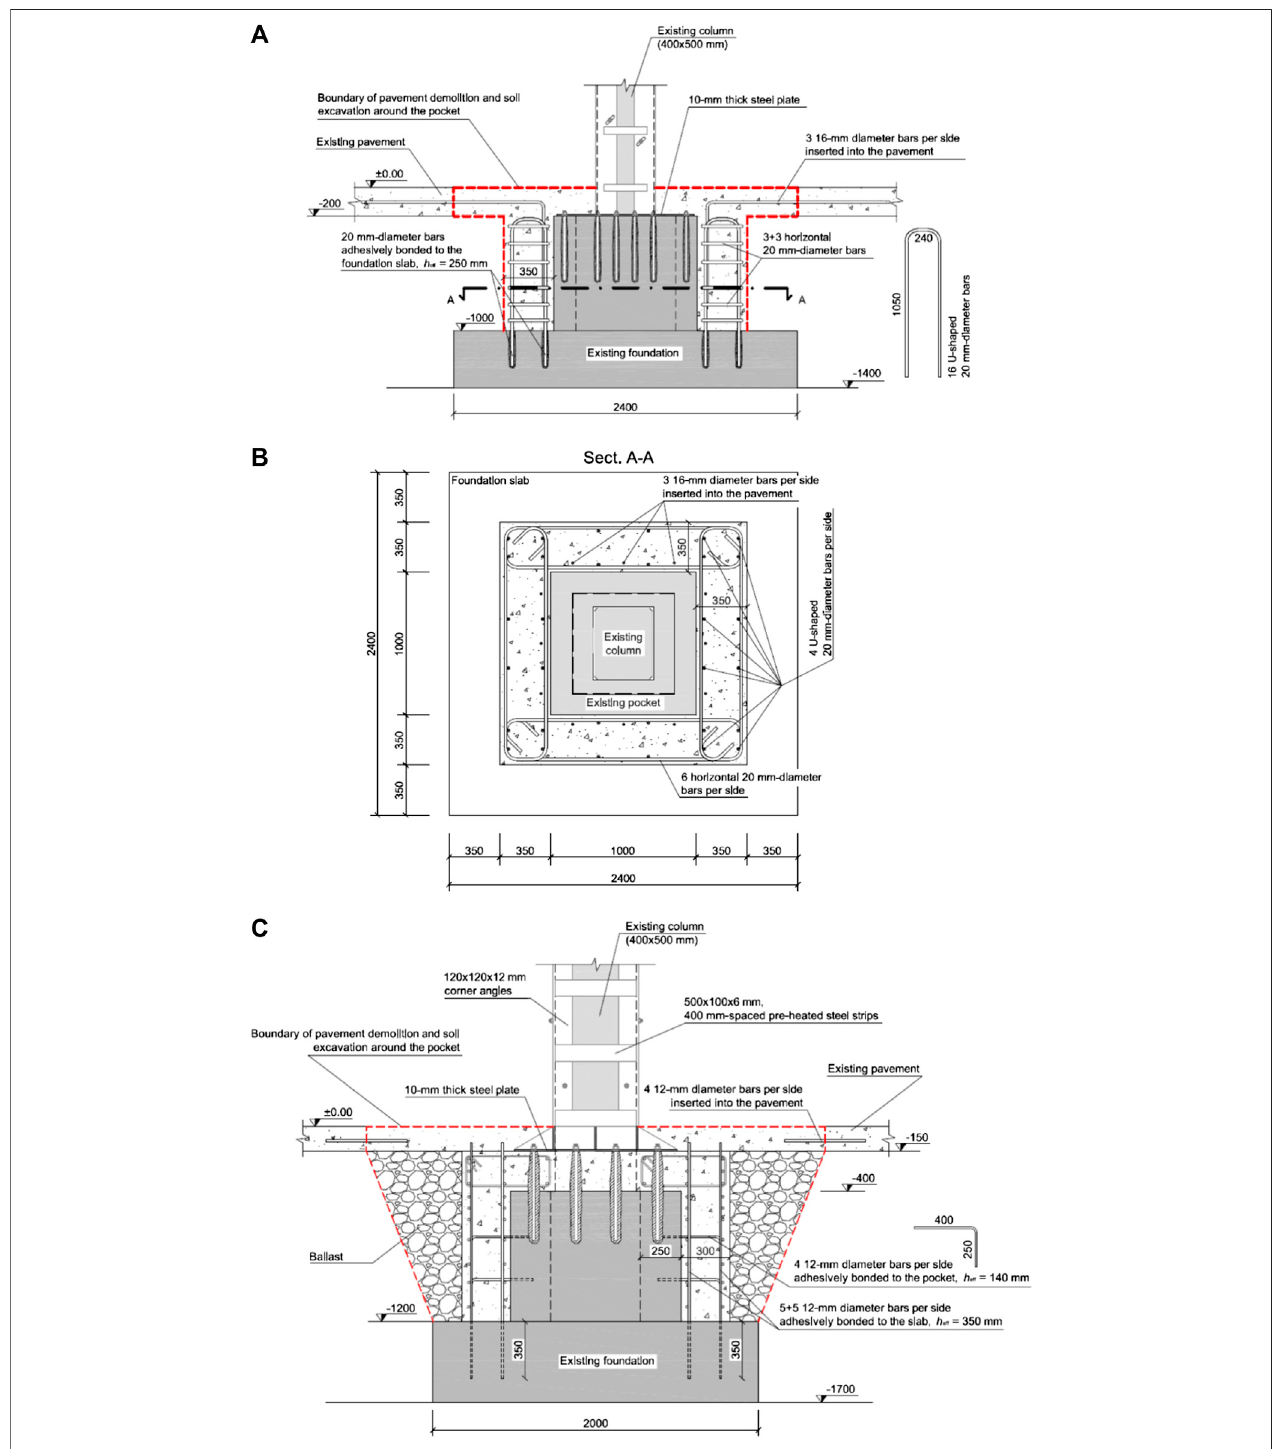
FIGURE 3 | Steel jacketing of precast columns in association with foundation strengthening: (A) vertical and (B) horizontal sectional views of pocket strengthened by a cast-in-contact RC jacket; (C) RC jacket applied to the sides and top of the existing pocket walls and connected to them by means of bonded ancors. Dimensions in mm.